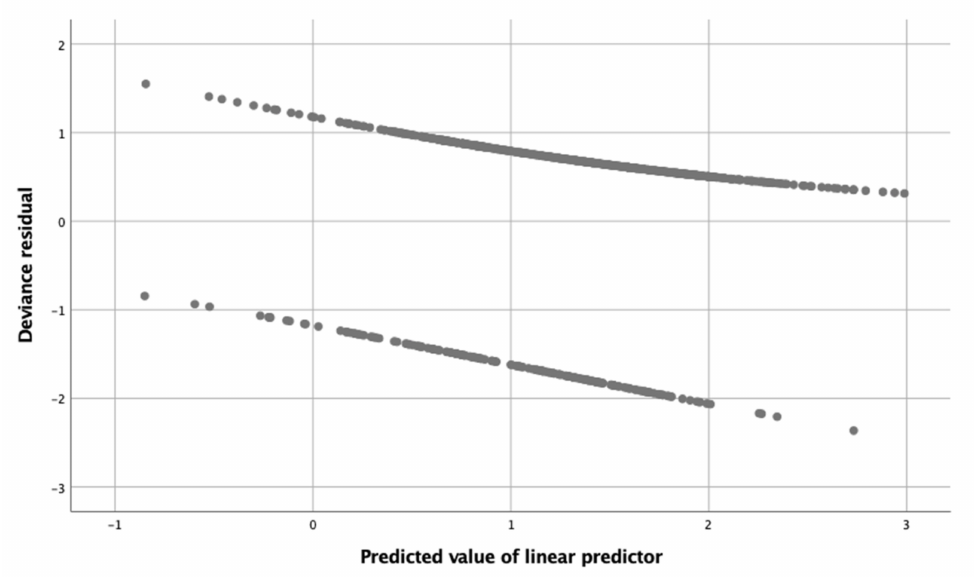
Figure 3. Scatterplot showing the relationship between deviance residuals and model